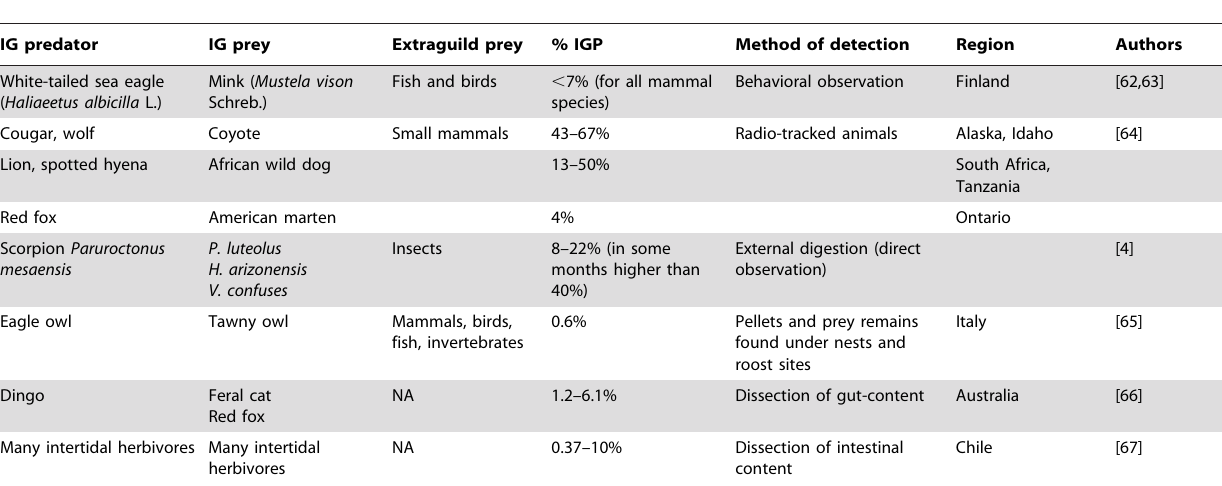
Table 2. Selected examples of intraguild predation under field conditions among different taxa.